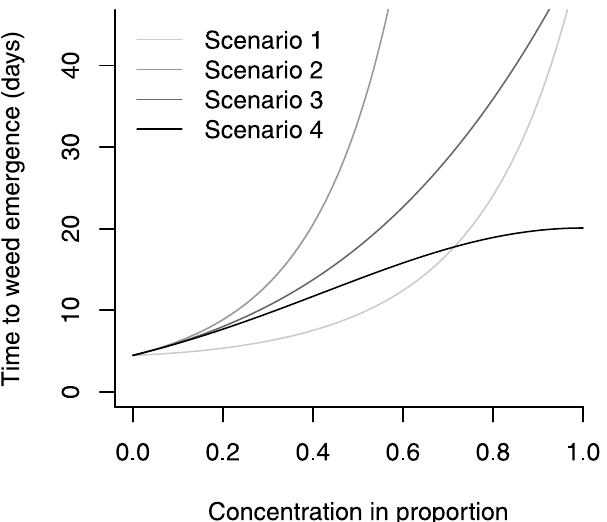
Fig 4. Simulation scenarios. The curves are designed by the values of regression parameters ( β 0 , β 1 , β 2 ) given in Table 1. The true values of Δ (the parameter to be estimated) are 0.477, 0.203, 0.241, and 0.267 in Scenarios 1, 2, 3, and 4, respectively.